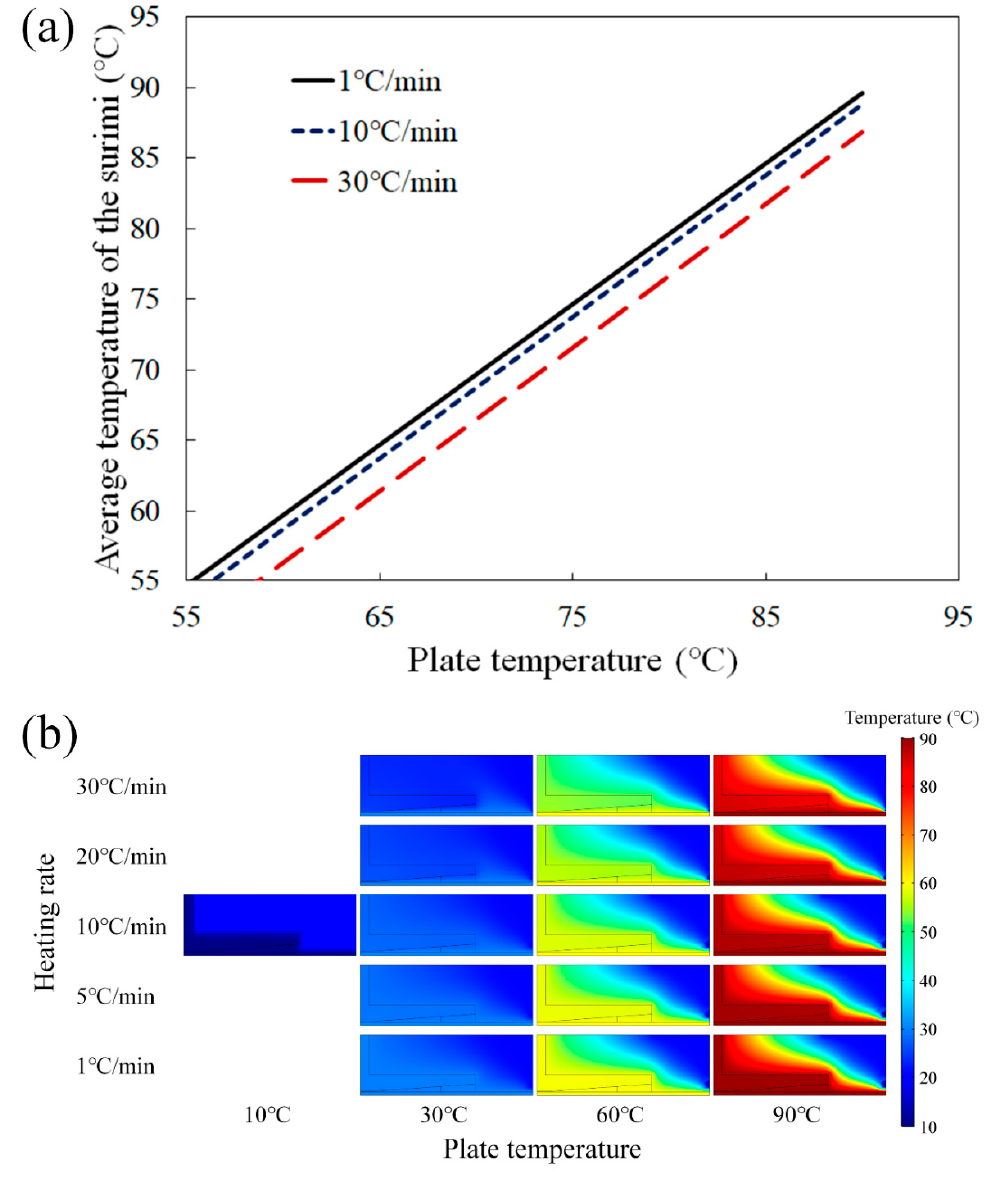
Figure 5. ( a ) Average temperature and ( b ) temperature distributions of Alaska pollock surimi during temperature sweep at different heating rates.